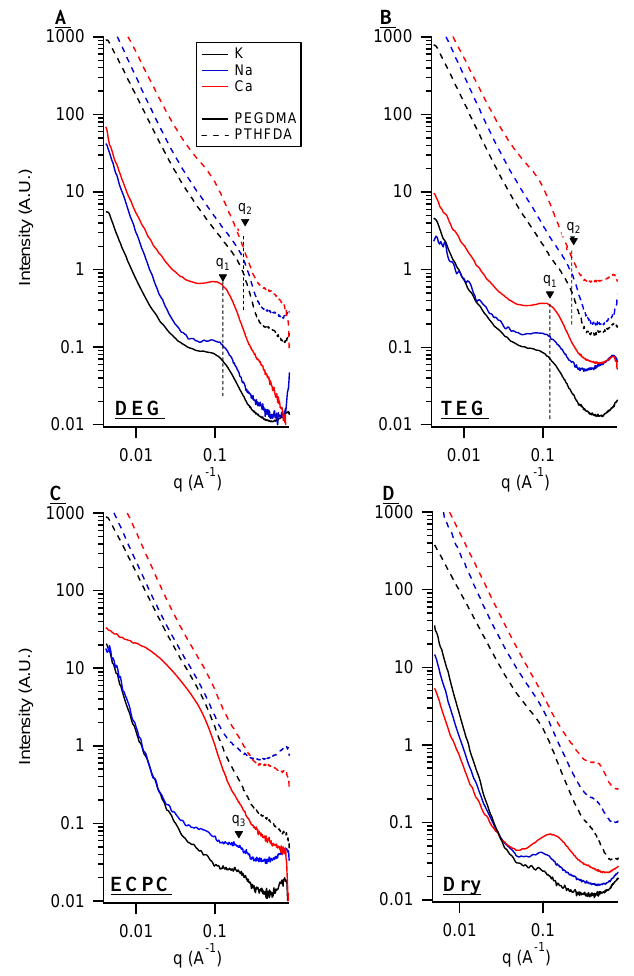
Figure 6. SAXS scattering for PEGDMA1000_low_SSM and PTHFDA1000_med_STFSIM polymers in ( A ) DEG, ( B ) TEG, ( C ) EC:PC, and ( D ) dry conditions. Spectra are offset vertically for clarity and are background subtracted.